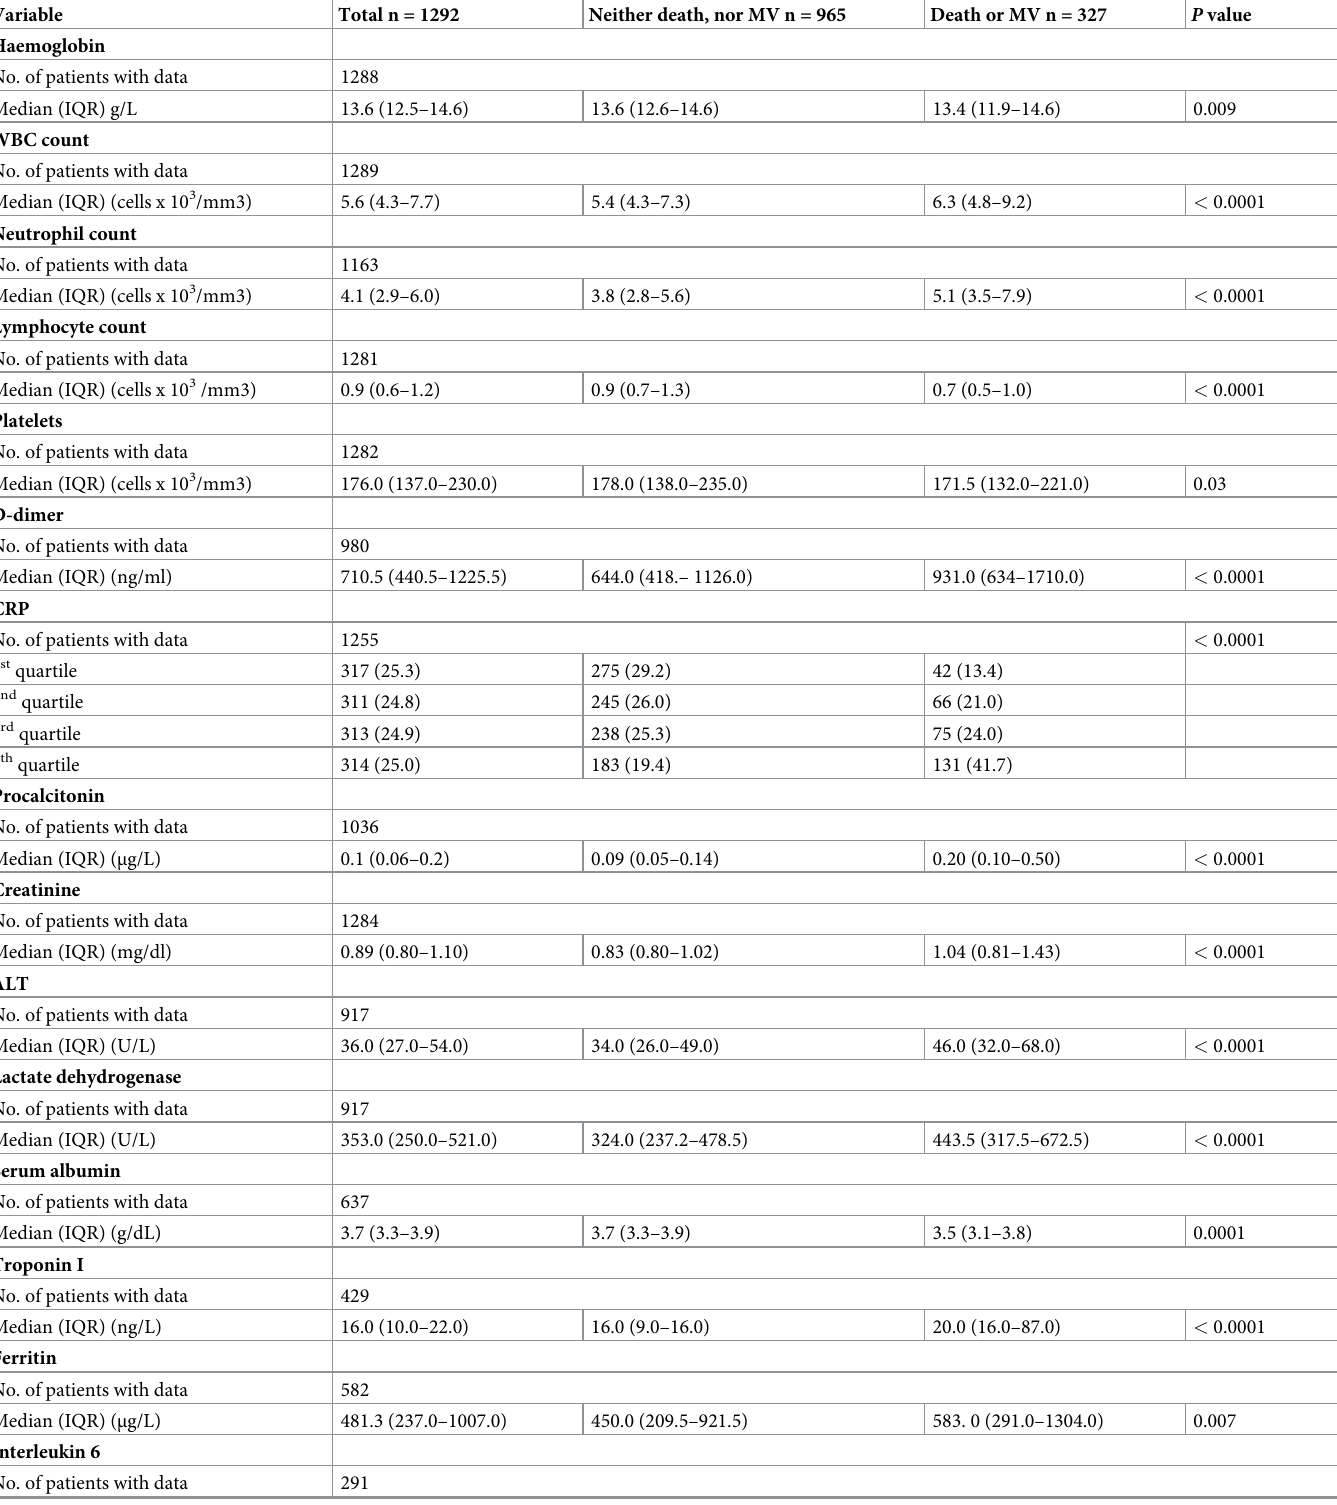
Table 2. Laboratory findings on